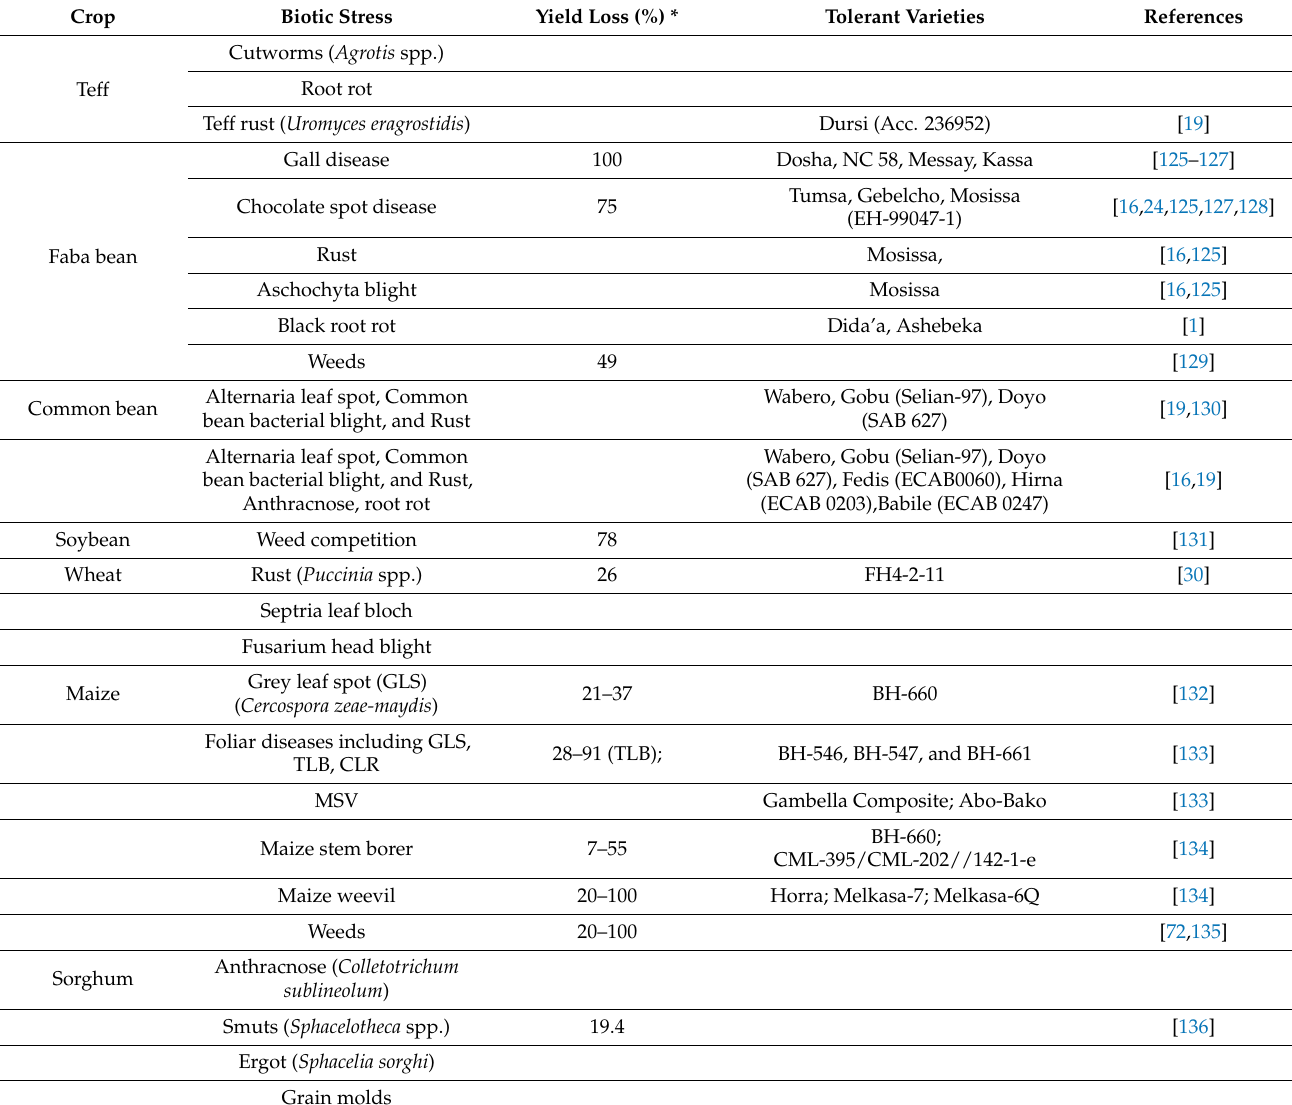
Table 5. Biotic stresses and extent of yield loss in selected